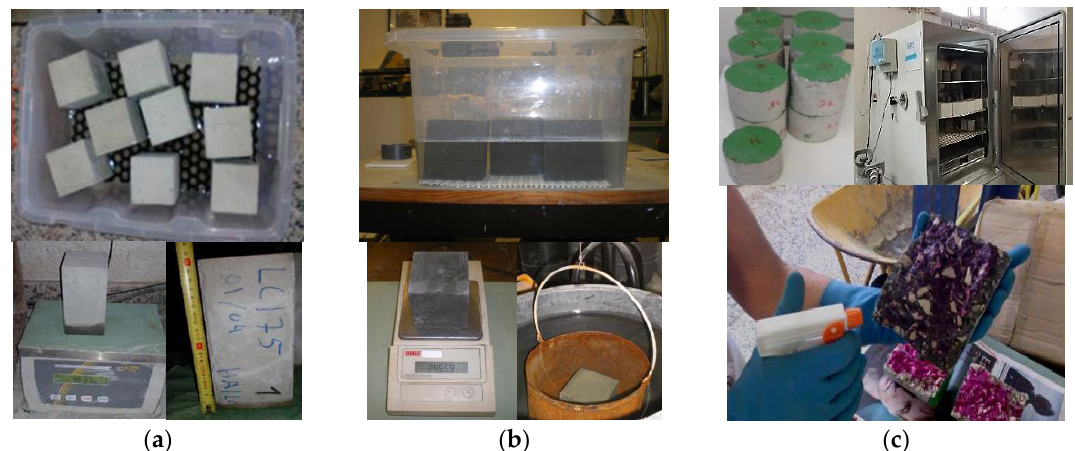
Figure 2. Durability tests: ( a ) water absorption through capillarity; ( b ) water absorption by immersion; ( c ) accelerated carbonation test.